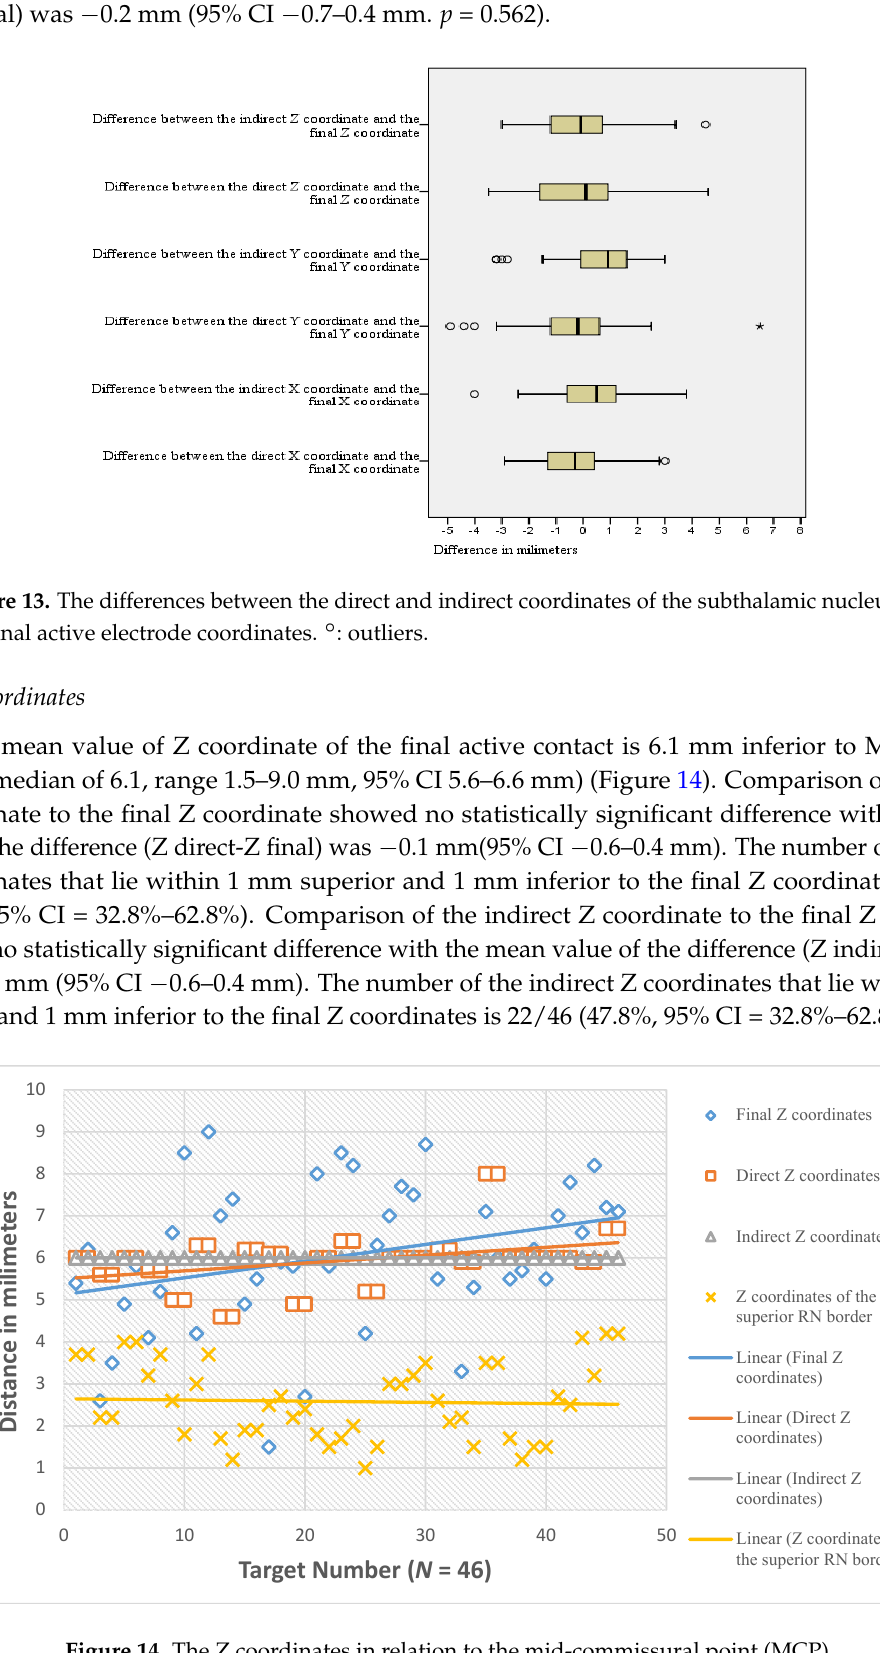
Figure 12. The Y coordinates in relation to the mid-commissural point (MCP).